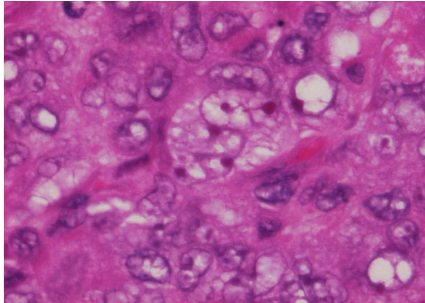
Figure 2: Mono- and multinucleated tumour cells. Note the pres- ence of nuclear vesicles and pink stained inclusions (haematoxylin and eosin × 400).